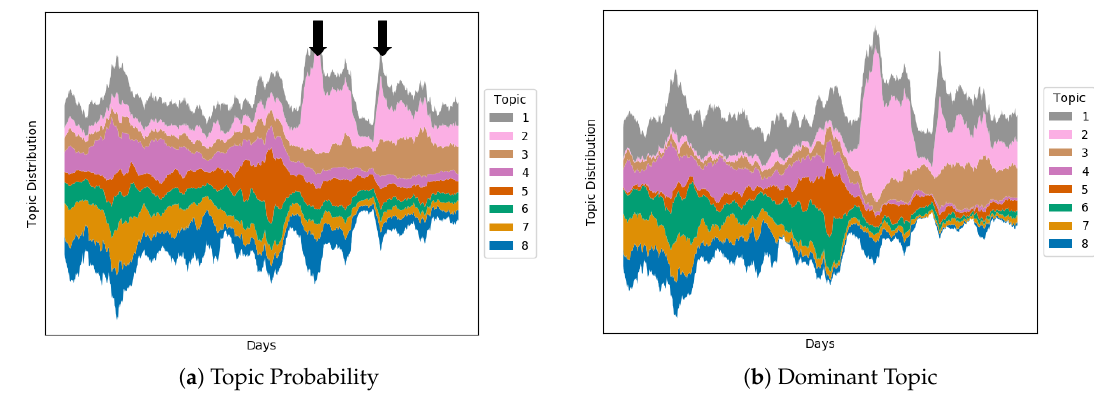
Figure 7. Temporal topic flow of PGR21 dataset with K = 8 where Topic 2 has significant peaks at certain